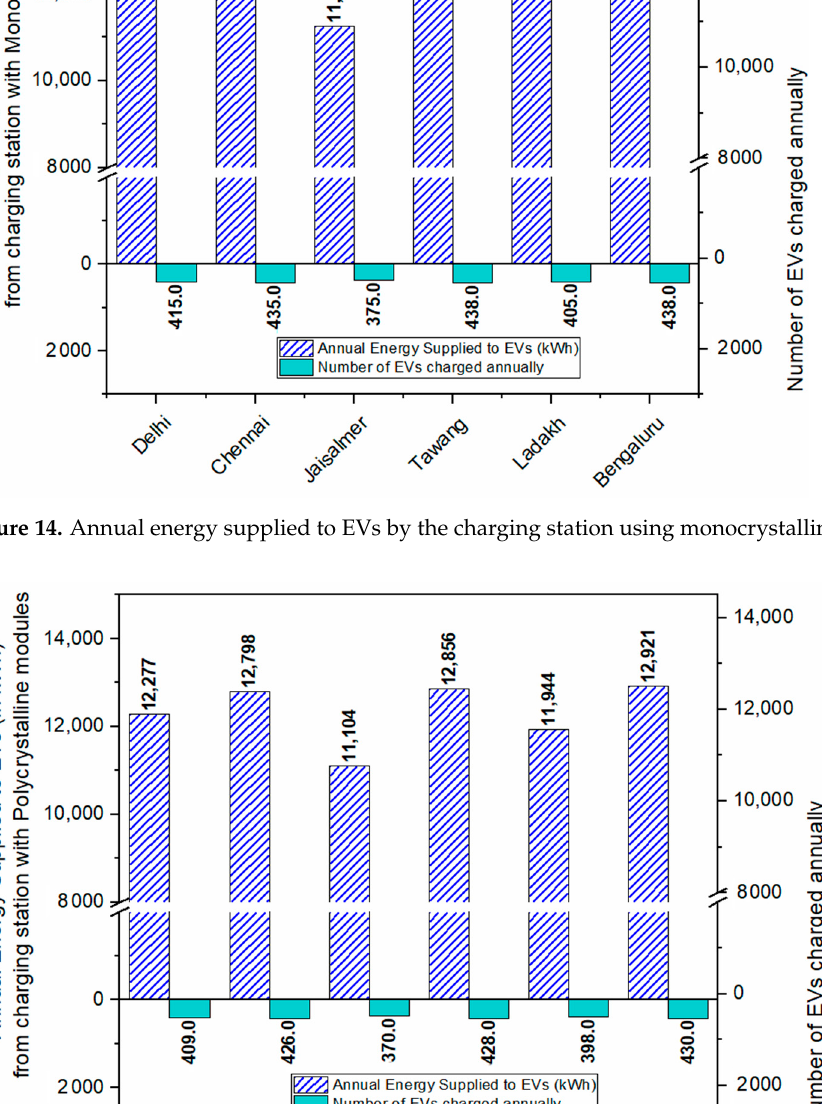
Figure 13. Monthly variation in energy supplied to EVs by the charging station using polycrystalline modules .